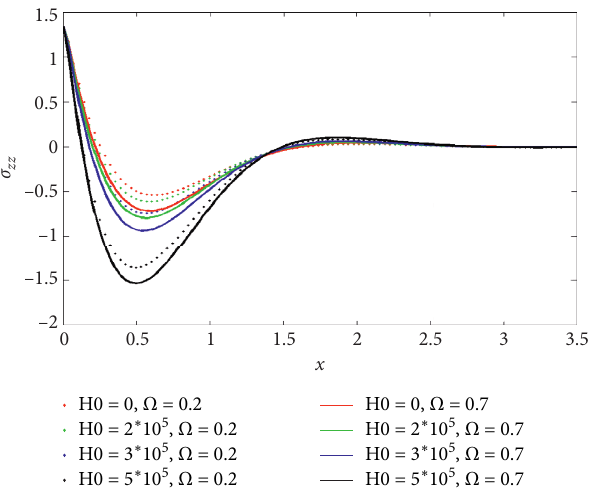
Figure 29: Stress σ